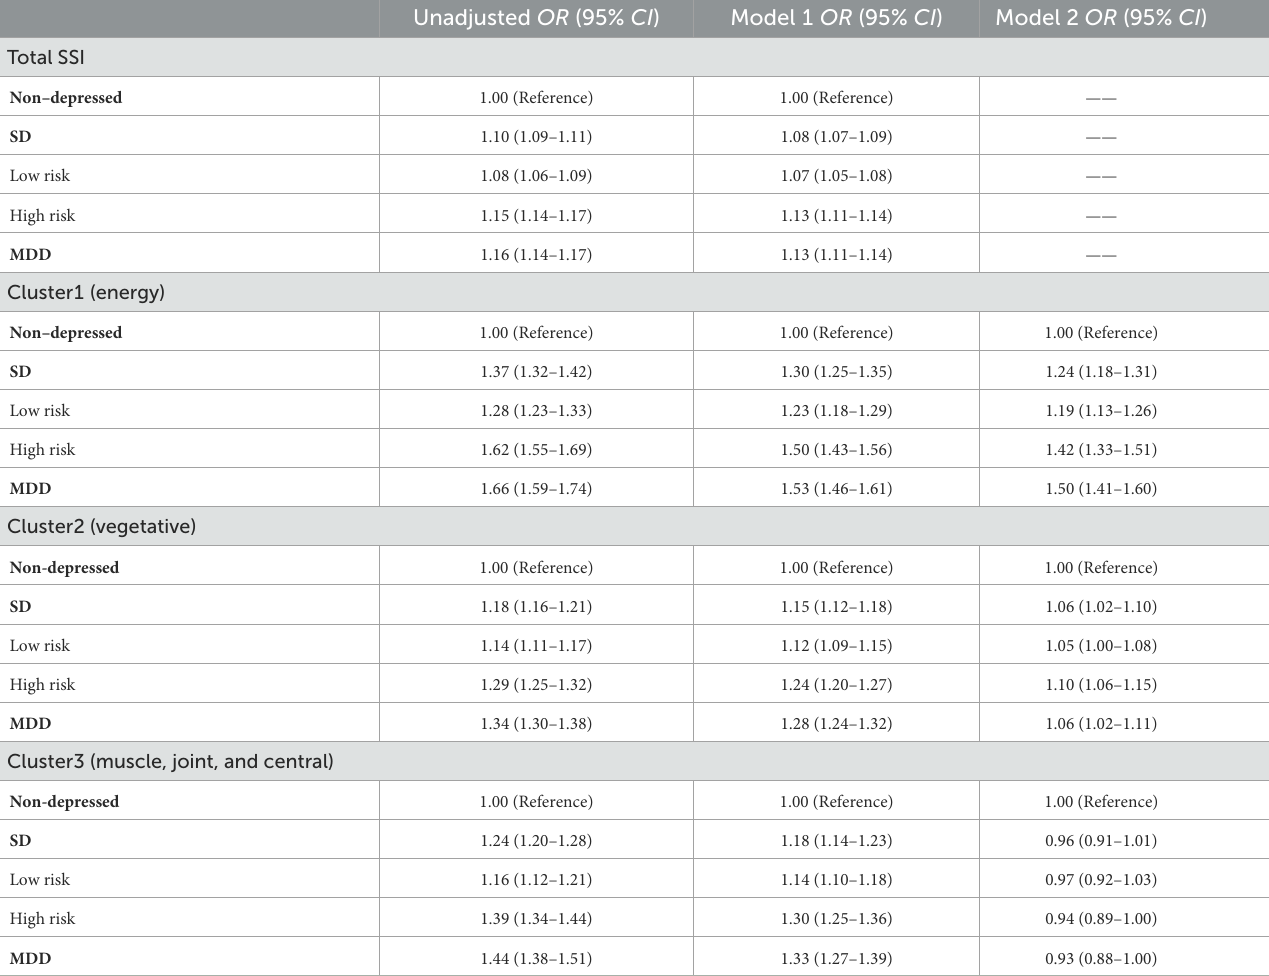
TABLE 3 Association between total SSI score or different cluster scores and the presence of SD or